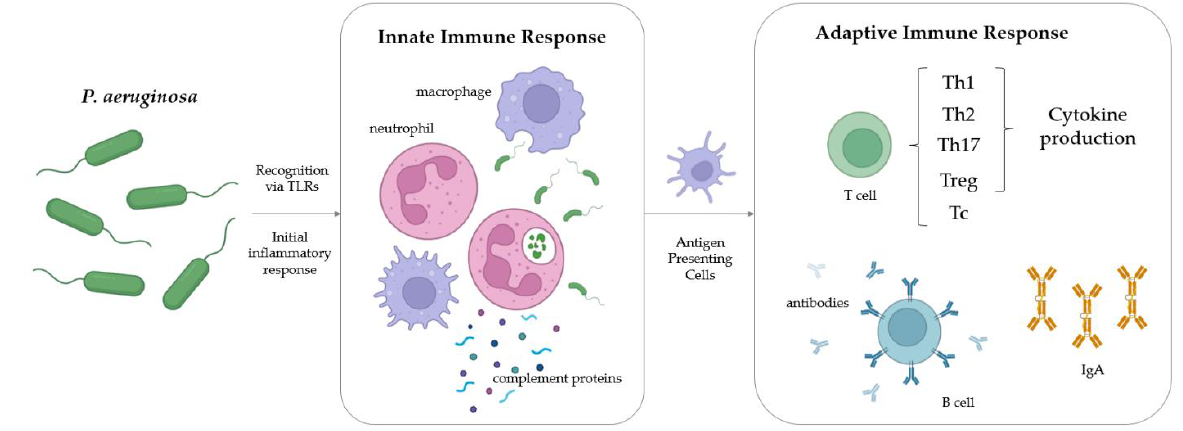
Figure 3. A summary of the key aspects of the host immune response against P. aeruginosa infec- tion.